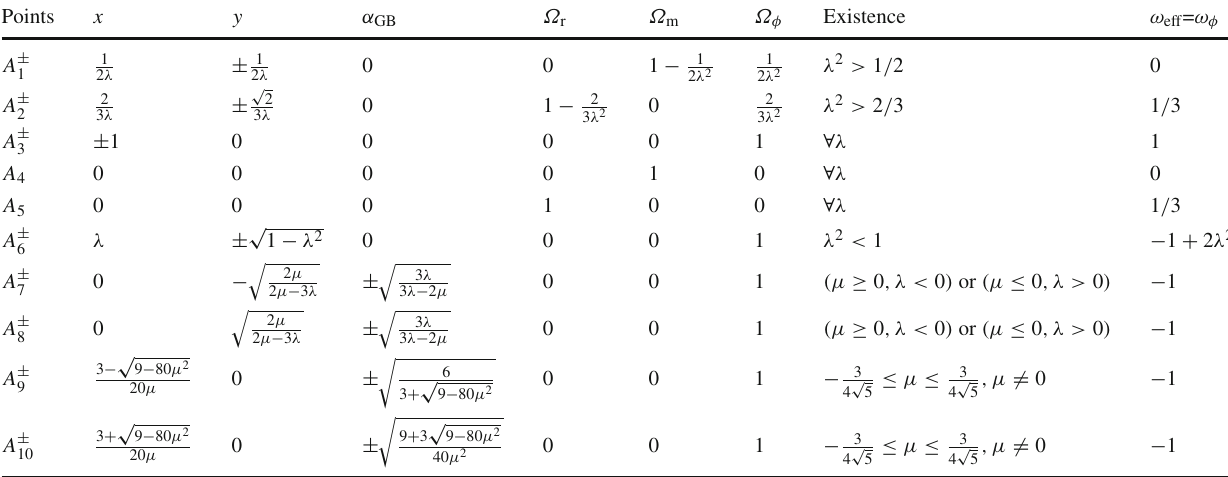
Table 1 The fixed points and cosmological parameters of the system Eqs. (34)–(37) with Δ = 1 and Γ = 1 Points x y α GB Ω φ Existence